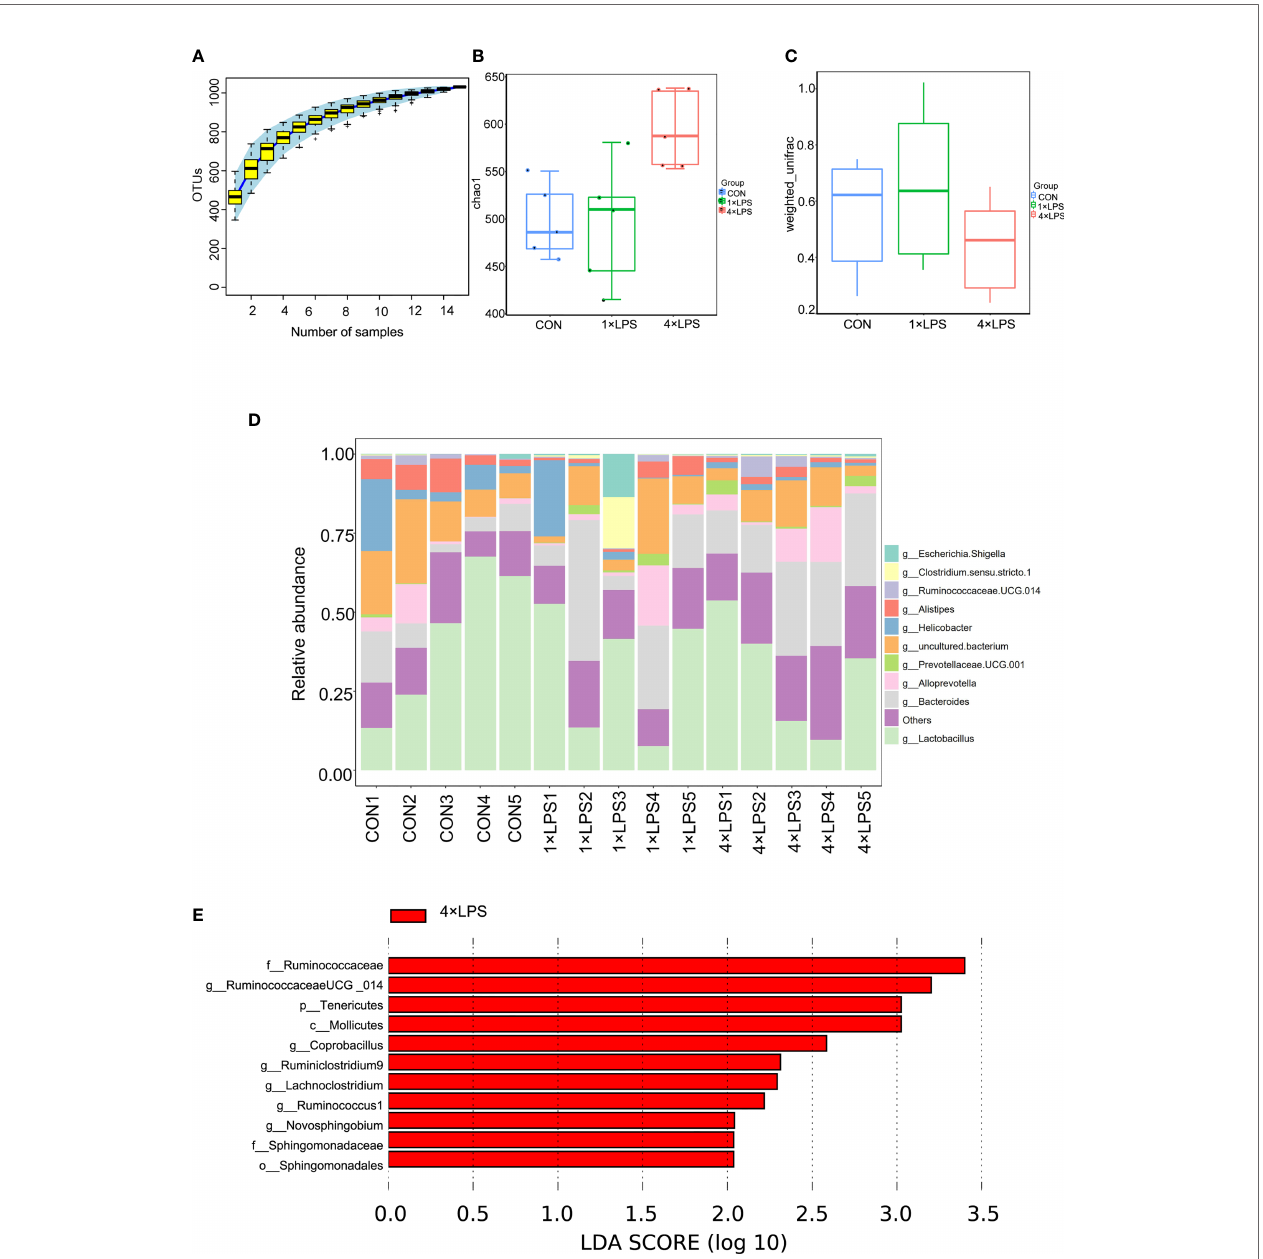
FIGURE 3 | Changes of intestinal fl ora. (A) The upward trend of the box chart of species accumulation curve is stable (n = 5 per group). (B) Comparison of microbial genus counts and a -diversity (as assessed by the chao 1) based on the genus pro fi les in the three groups (Control vs 4×LPS, p<0.05; 1×LPS vs 4×LPS, p <0.01, by t test). (C) Comparison of microbial genus counts and b -diversity (as assessed by the unweighted unifrac) based on the genus pro fi les in the three groups (1×LPS vs 4×LPS, p < 0.05, by t test). (D) Composition ratio of three groups of samples at genus level. (E) The red area in the histogram of LDA value distribution indicates the microbial groups that play an important role in 4 × LPS. Only the species whose LDA score is greater than the set value (the default setting is 2) are shown in the graph, and the length of the histogram represents the LDA value. The species whose LDA value is greater than 2 by default are Biomarker with statistical differences between groups. Source data are provided as a Source Data fi le. 1×LPS: immune training; 4×LPS: immune tolerance; LDA: Linear Discriminant